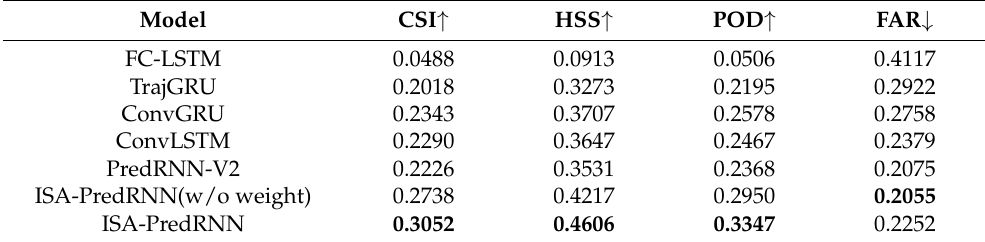
Table 3. Comparison of the experimental results at the level of 30 dBZ.